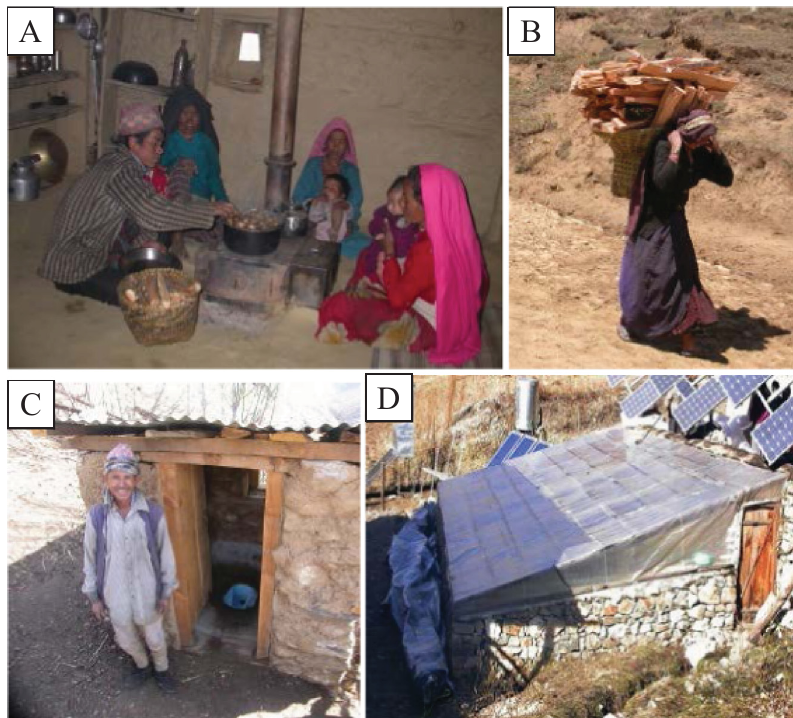
Fig. 1. (A) Alivingroomwithsmokelessmetalstove;(B)womancarrying fi rewood;(C)pitlatrine;(D)localgreenhouse,all ©